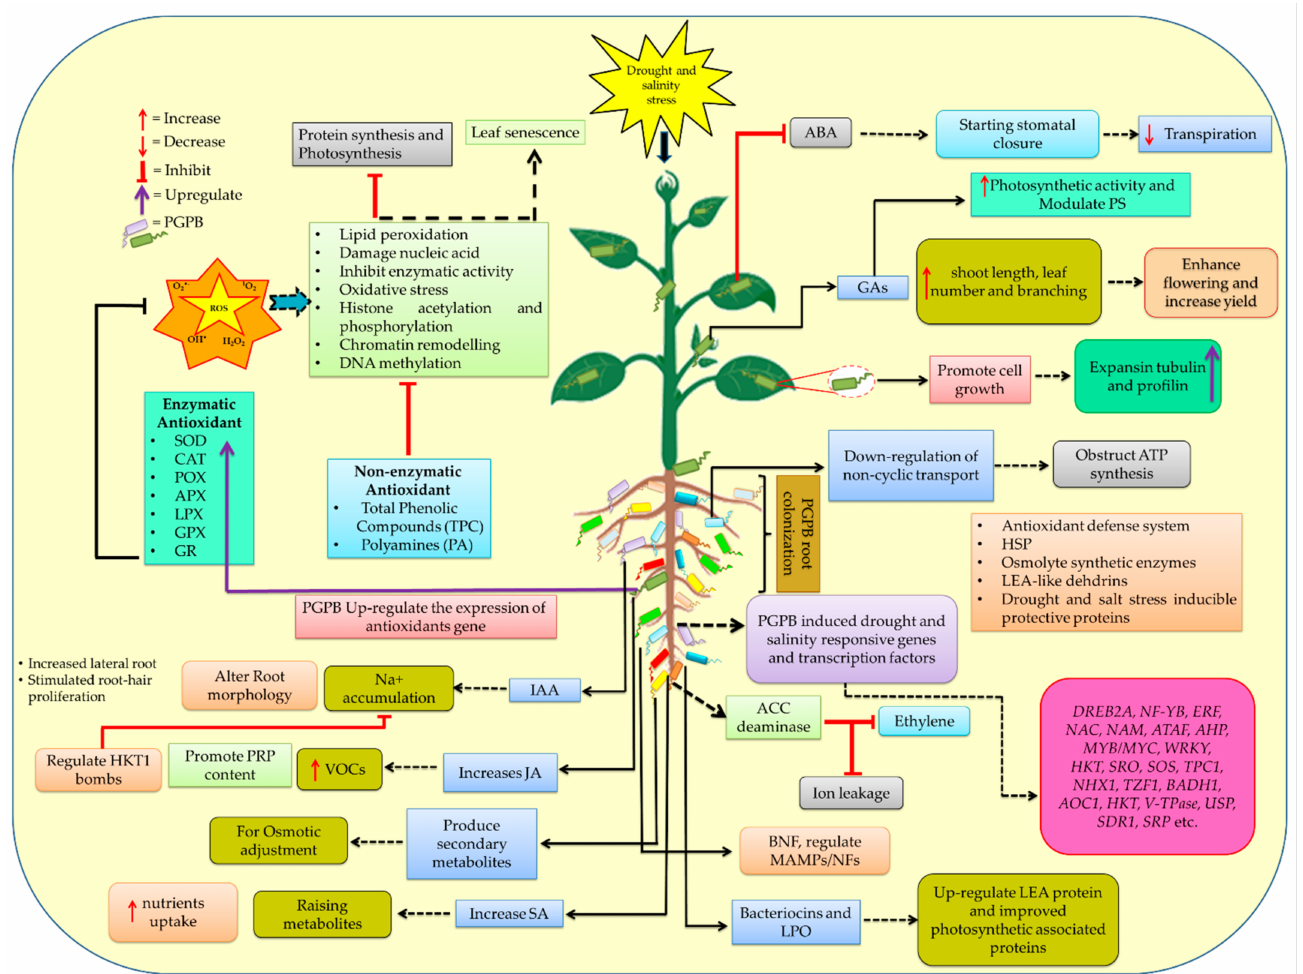
Figure 2. Schematic representation of plant growth-promoting bacteria (PGPB)—mediated drought and salinity stress tolerance in plants. During drought stress, the plant itself and PGPB are able to detoxify ROS into stable nonreactive compounds. SOD—superoxide dismutase; CAT—catalase; GR—glutathione reductase; GPX—glutathione peroxidase; MAMPs—microbe-associated molecular patterns; NFs—nodulation factors. PGPB modulates the signaling pathways involved in drought and salt response biochemically and molecularly. Drought response is primarily regulated by ABA, which controls other signaling pathways such as SA, IAA, JA, and GA. SA—salicylic acid; ABA—abscisic acid; JAs—jasmonic acid; GAs—gibberellins; IAA—indole-3-acetic acid. PGPR also modulates transcription factors (TFs) that are essential in the drought and salt response and tolerance. NAM, ATAF, NAC, MYB/MYC, and WRKY —transcription factors; NF-Y —nuclear factor-Y; ERF —ethylene- responsive element-binding factor; LCOs —Lipo-chitooligosaccharides; BNF —Biological Nitrogen Fixation; AHP —cytokinin-related genes; AOC1 —allene oxide cyclase; HKT —High-affinity K + trans- porters; NHX1 —vacuolar Na + /H + antiporter gene; BADH1 —Betaine aldehyde dehydrogenase 1; V- ATPase —Vacuolar-H + -pyrophosphatase; USP —Cytosolic universal stress protein; SDR1 —salt and drought-responsive gene; LEA —late embryogenesis abundant; TIP1 —Tonoplast AQP gene; SRP —Salt-responsive protein-encoding gene; SOS1 —Salt overly sensitive gene. Figure created with BioRender.com (https://app.biorender.com/biorender-templates)—accessed on 27 January